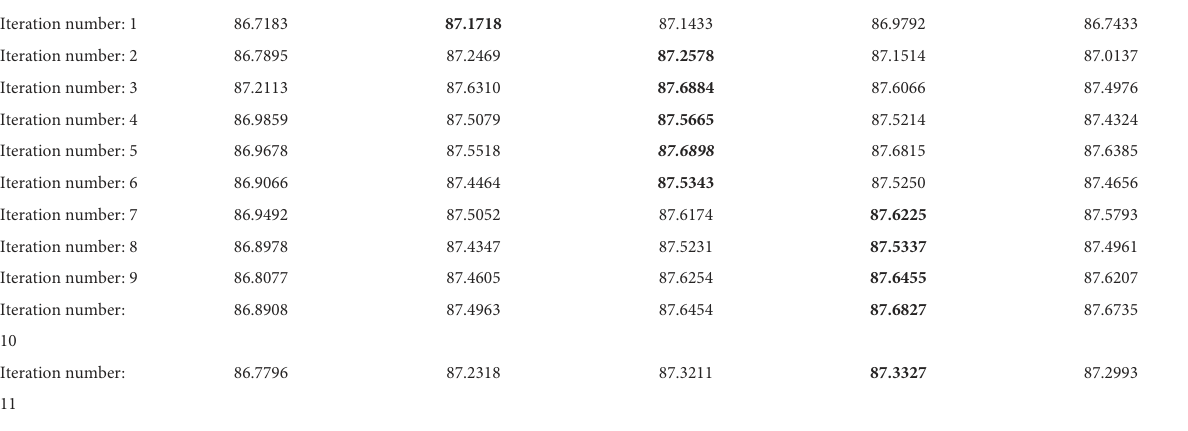
TABLE 3 The average dice scores (%) of low-scale network with different parameters on mouse brain test